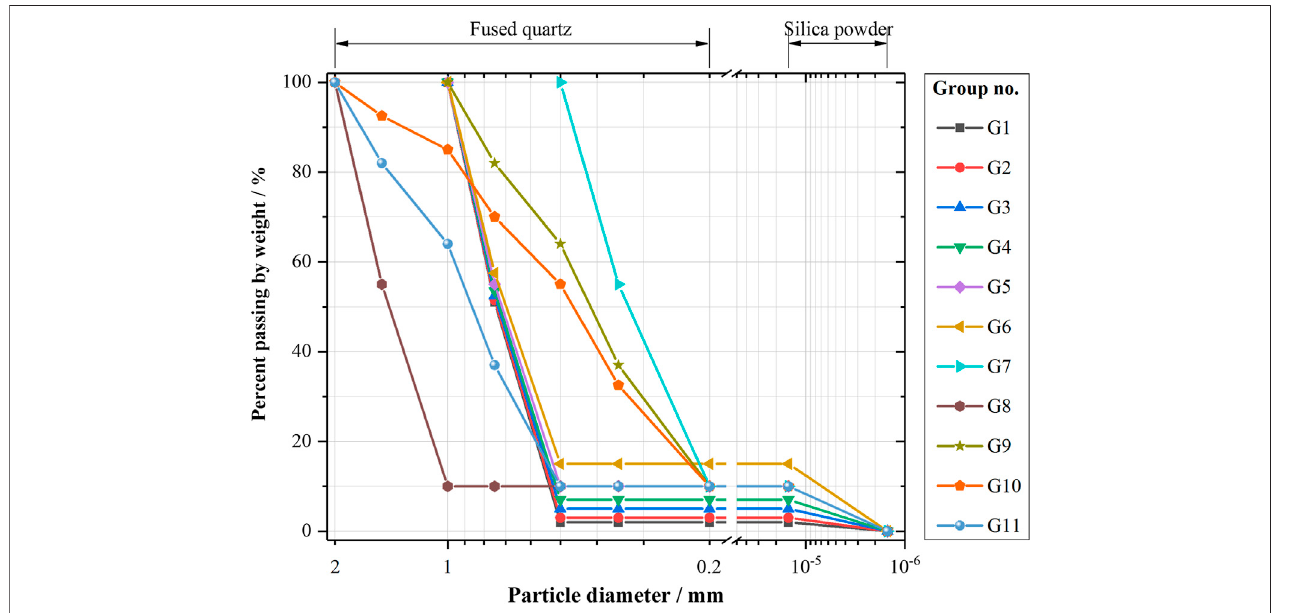
FIGURE 2 | Particle size distribution curves of all groups in the